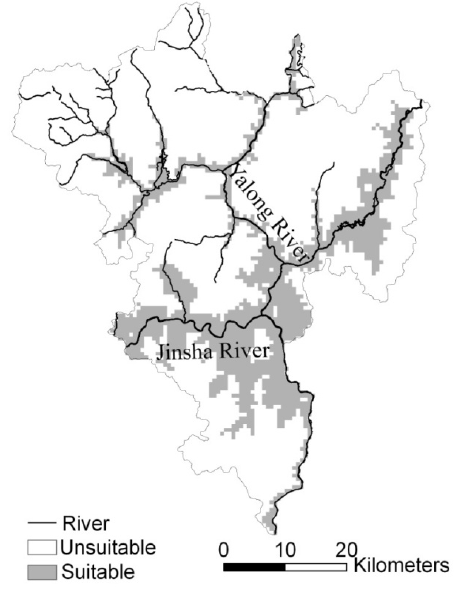
Figure 3. Spatial distribution of suitable land for Jatropha plantation in